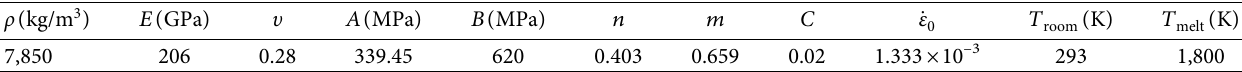
Table 4: Material parameters of the Q355 steel [44].